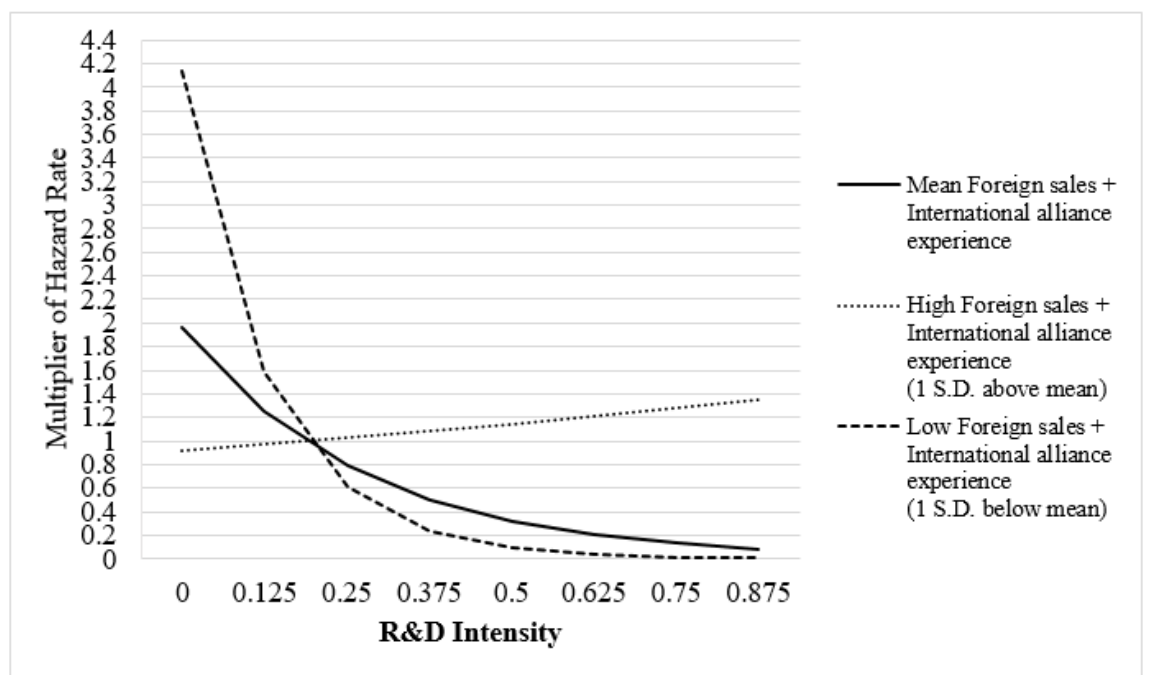
Figure 1. R&D Intensity and International Alliance Experience Plus Foreign Sales Intensity.